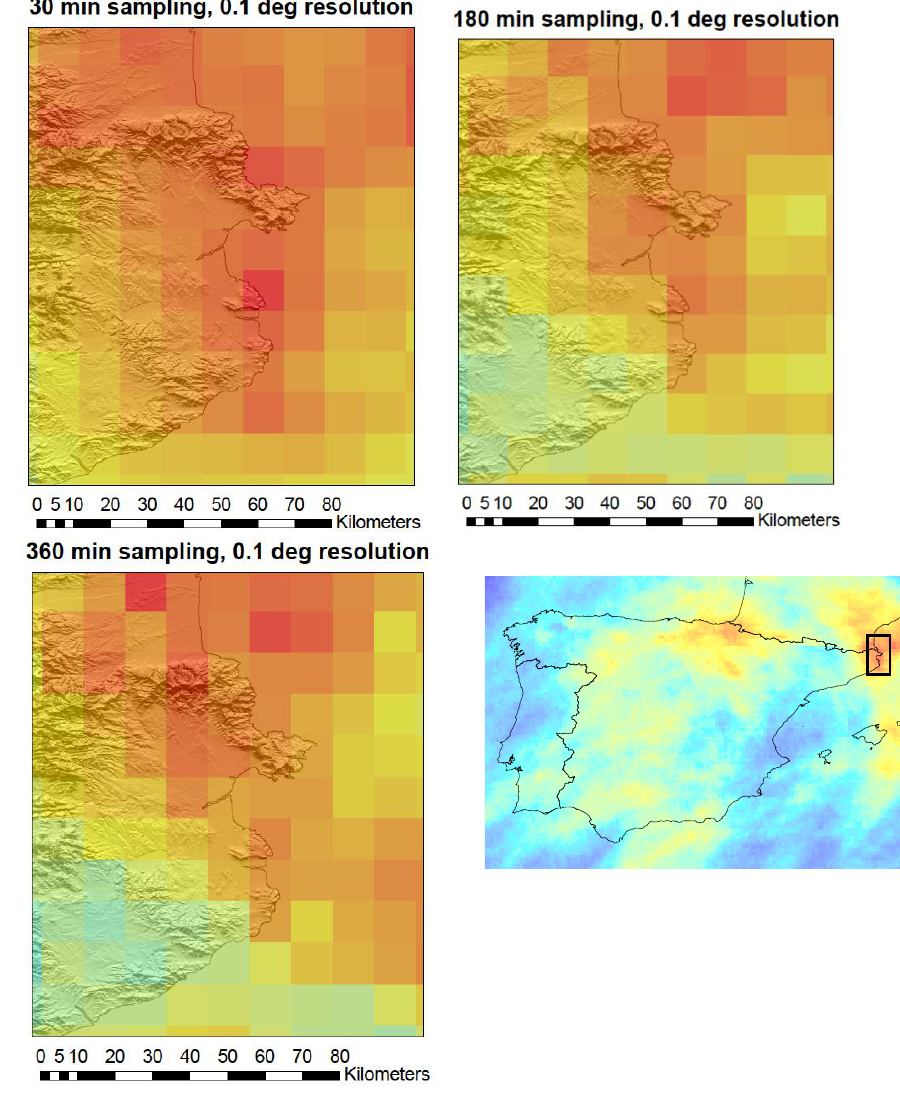
Figure 8. Errors in the location of the maximum monthly precipitation as temporal resolution degrades. The nominal truth (30-min, 0.1° resolution, upper/left) locates the maxima over mainland Spain, in Catalonia. A 3-h sampling places the maximum over the Gulf of Leon (upper/right), and a 6-h sampling over mainland France (bottom/left).